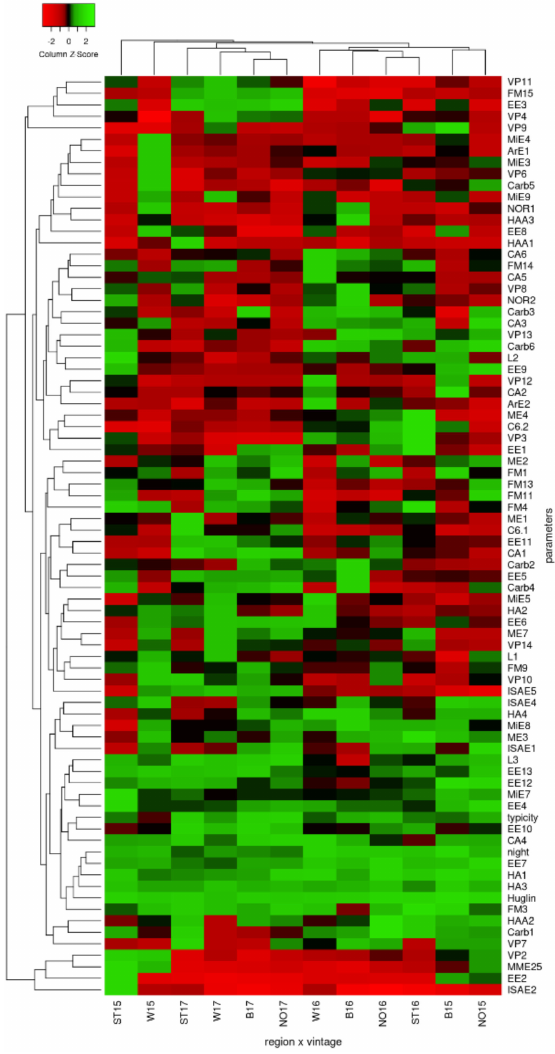
Figure A1. Heatmap: ST: Styria; W: Vienna; B: Burgenland; NO: Lower Austria; an explanation of the flavouring abbreviation can be found in Supplementary Materials Table